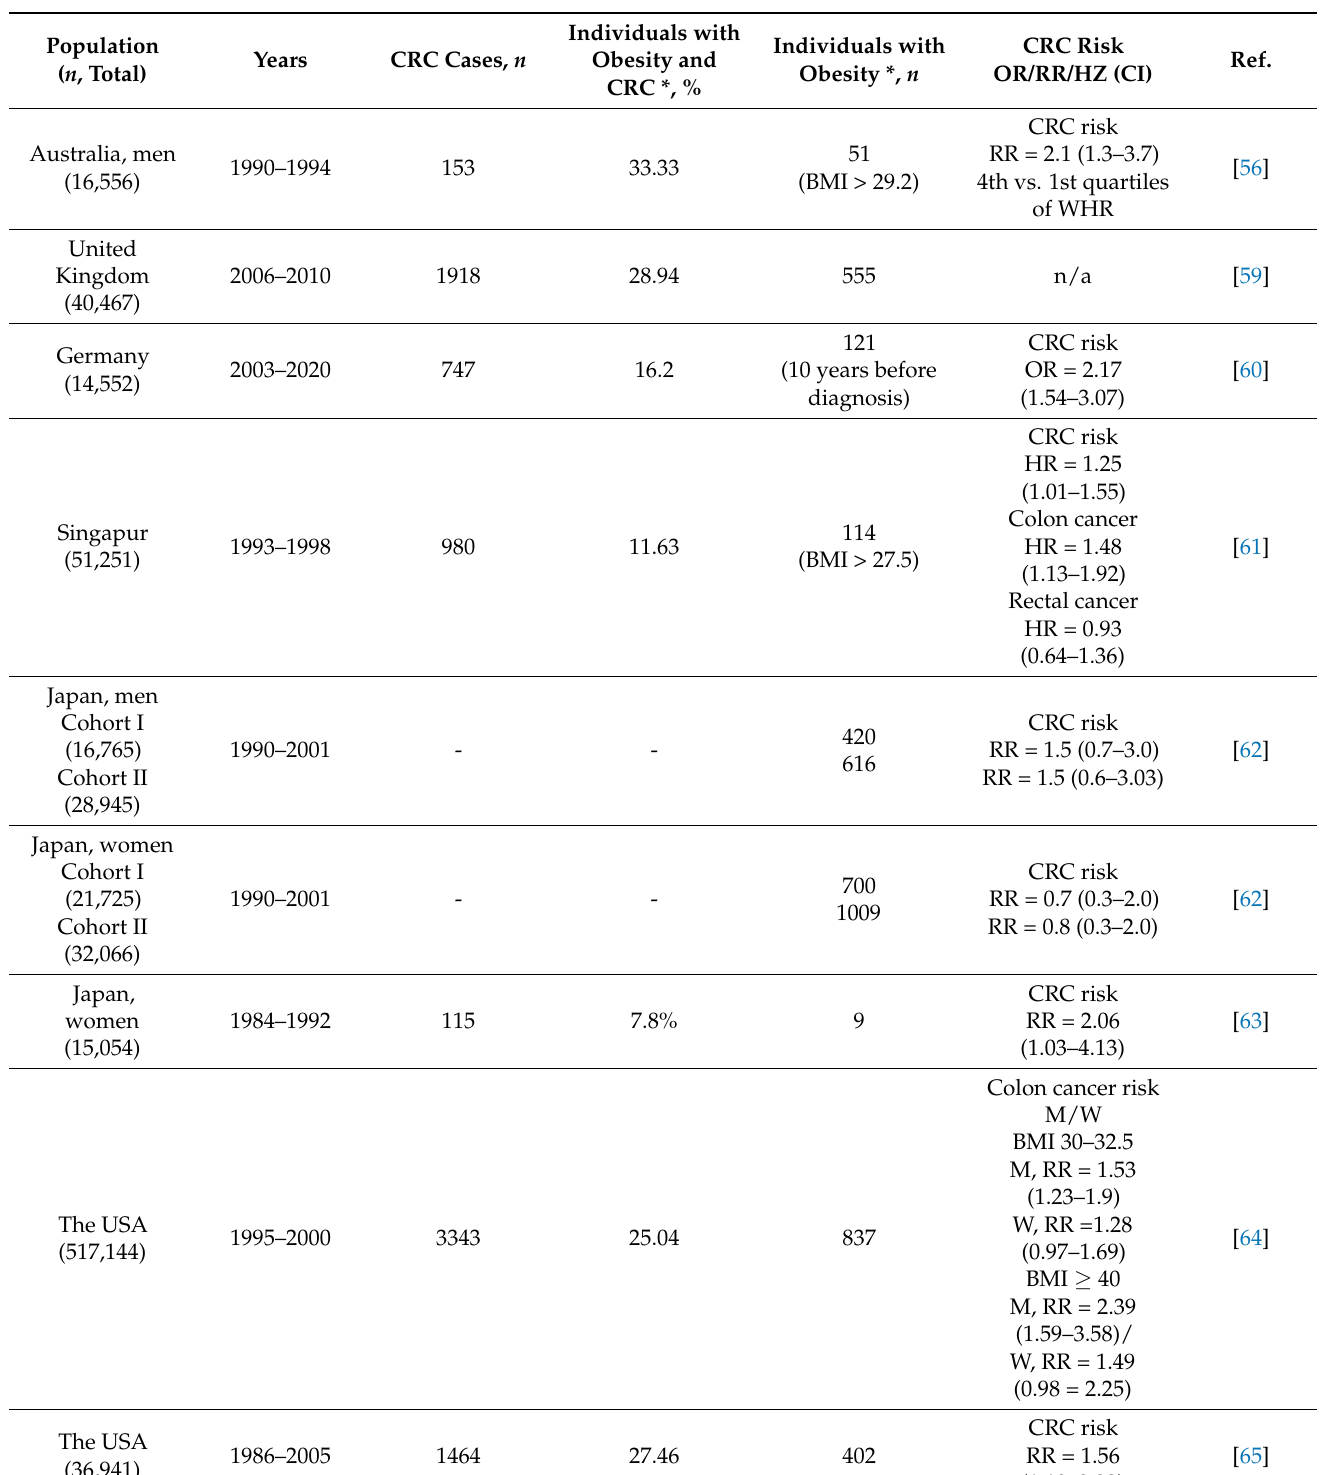
Table 1. Obesity prevalence among CRC cases and its relation with chosen CRC